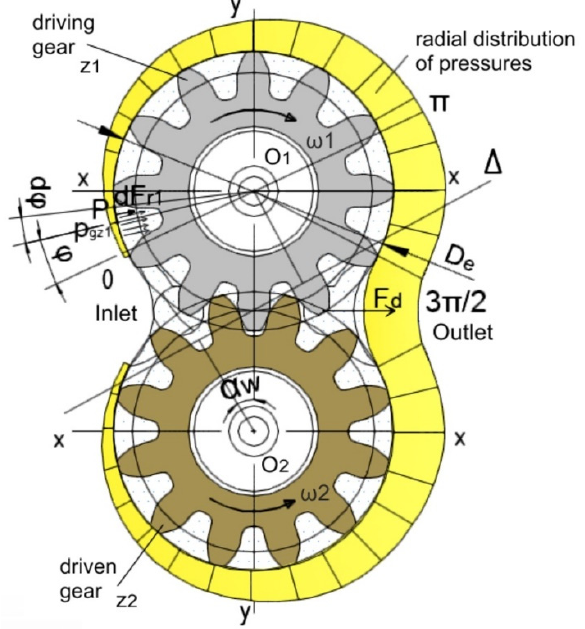
Figure 6. Radial distribution of pressures acting on the gear .